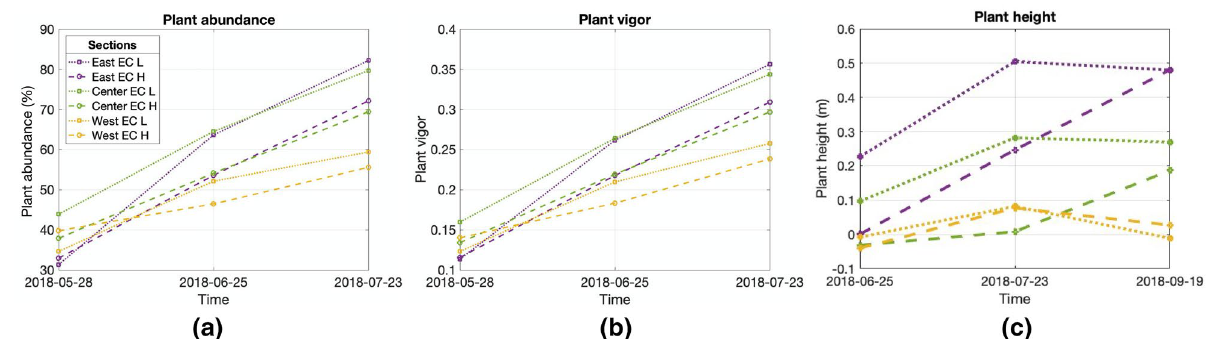
Figure 9. Run charts for time series of plant characteristics: ( a ) plant spatial abundance; ( b ) plant-specific vigor computed in terms of GCC index; ( c ) plant height. The data are reported as average values for each of the three sections (east, center, west, idnetified by different colors), considering high and low values of soil EC a